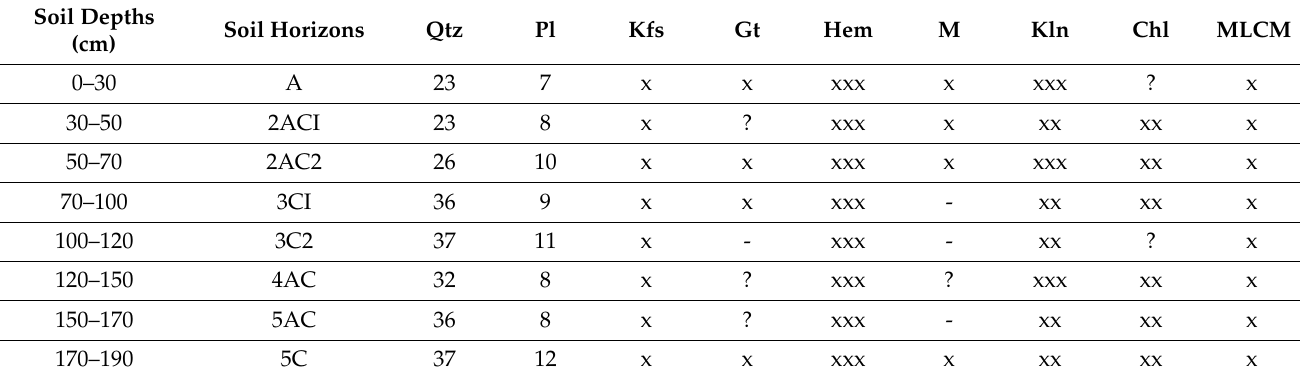
Table 2. Semi-quantitative mineral compositionofthe<2mmfraction(afterdilutionofcarbonateminerals). Qtz: quartz. Pl: plagioclase. Kfs: potassium feldspar. Gt: goethite. Hem: hematite. M: micaceous minerals (mica and illitic material). Kln: kaolinite. Chl: chlorite. MLCM: mixed-layer clay minerals in which type